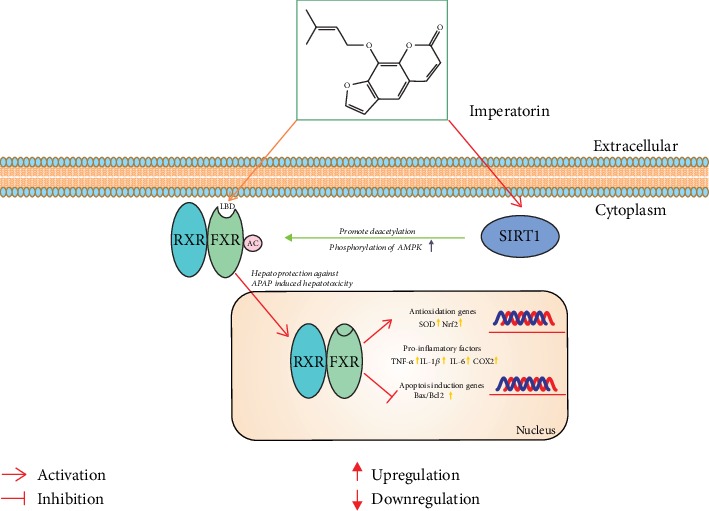
Proposed mechanisms of IMP mediating activation of SIRT1 and FXR to protect mice against APAP overdose-induced liver injury. IMP exerts the physiological effect of hepatoprotection against APAP overdose-induced liver injury via directly activating FXR signaling and indirectly facilitating the SIRT1-dependent deacetylation of FXR. Meanwhile, IMP can also promote the SIRT1-dependent phosphorylation of AMPK, which leads to FXR heterodimerization with the retinoid X receptor (RXR) and binds to FXR response elements (FXREs) to upgrade expression of FXR-targeted genes involved in antioxidant, anti-inflammatory, and antiapoptosis effect.